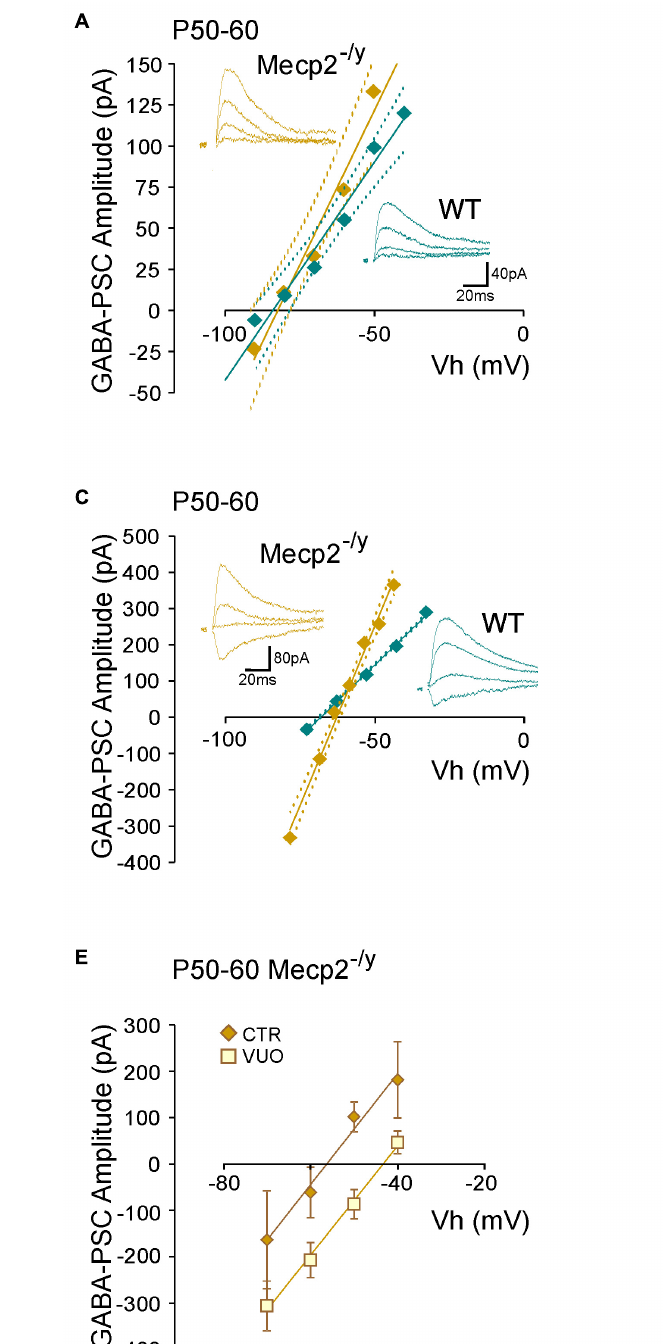
Frontiers in Cellular Neuroscience |